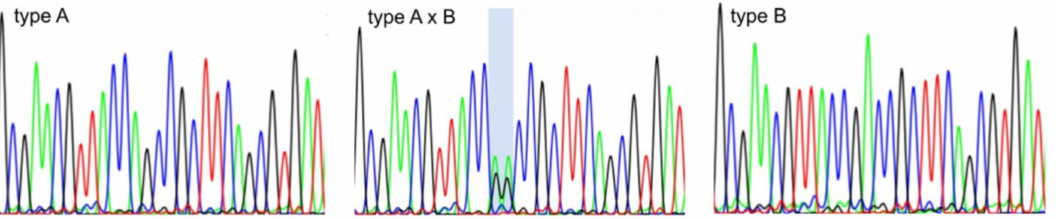
Figure 2. Comparison of parts of abi chromatograms showing polymorphism of ITS sequences in Bjerkandera adusta . The presence of both types of ITS sequence are shown on a blue background. To evaluate the polymorphism at nucleotide position 522 in ITS sequences of B.